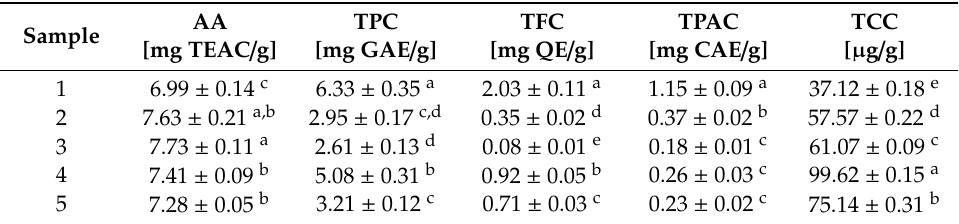
Table 3. The results of biological activity of Rosa canina samples.